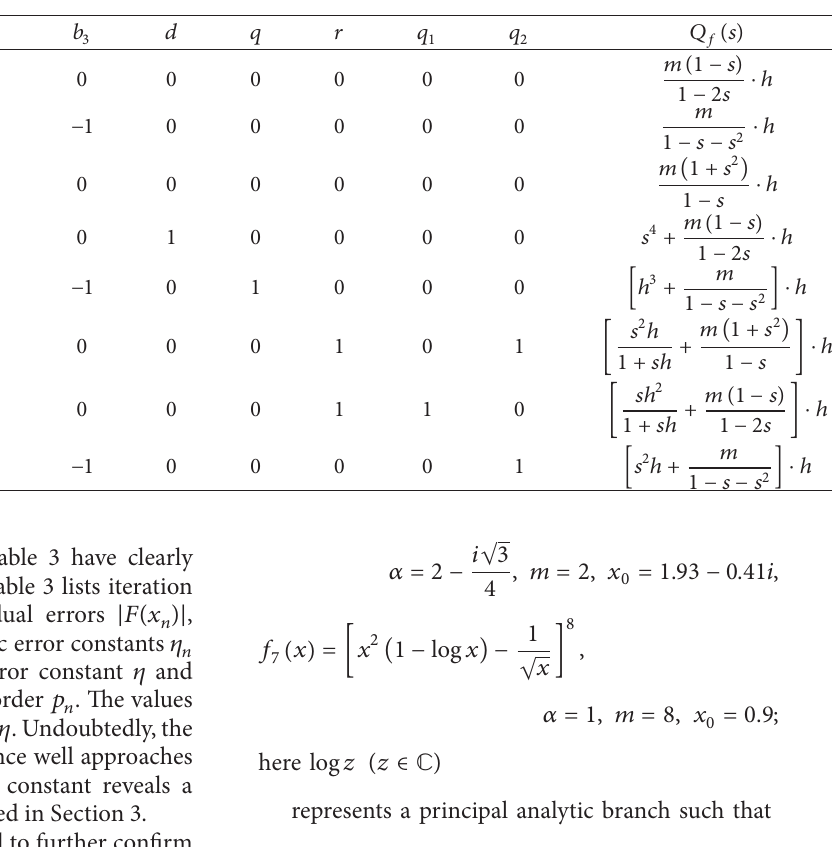
Table 2: Typical subcases of Case 2 with selected